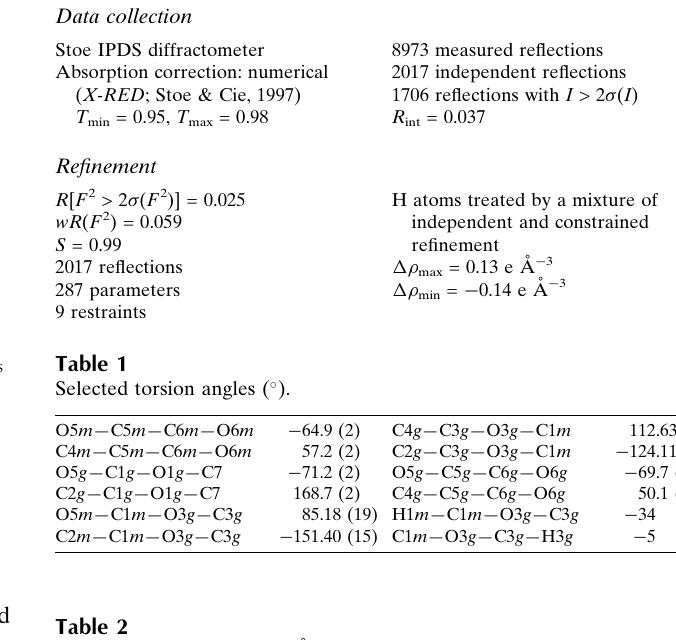
Hydrogen-bond geometry (A˚ , (cid:3)